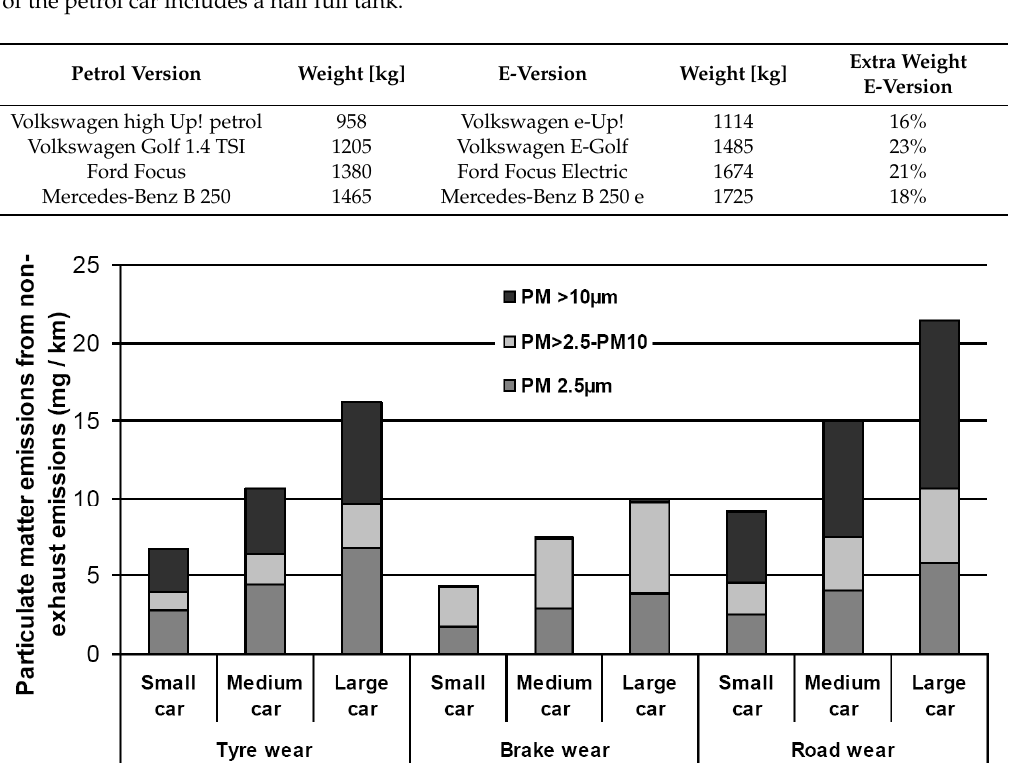
Figure 4. Non-exhaust particulate matter (PM) emissions by source and car size, from Simons [113] based on Ntziachristos and Boulter